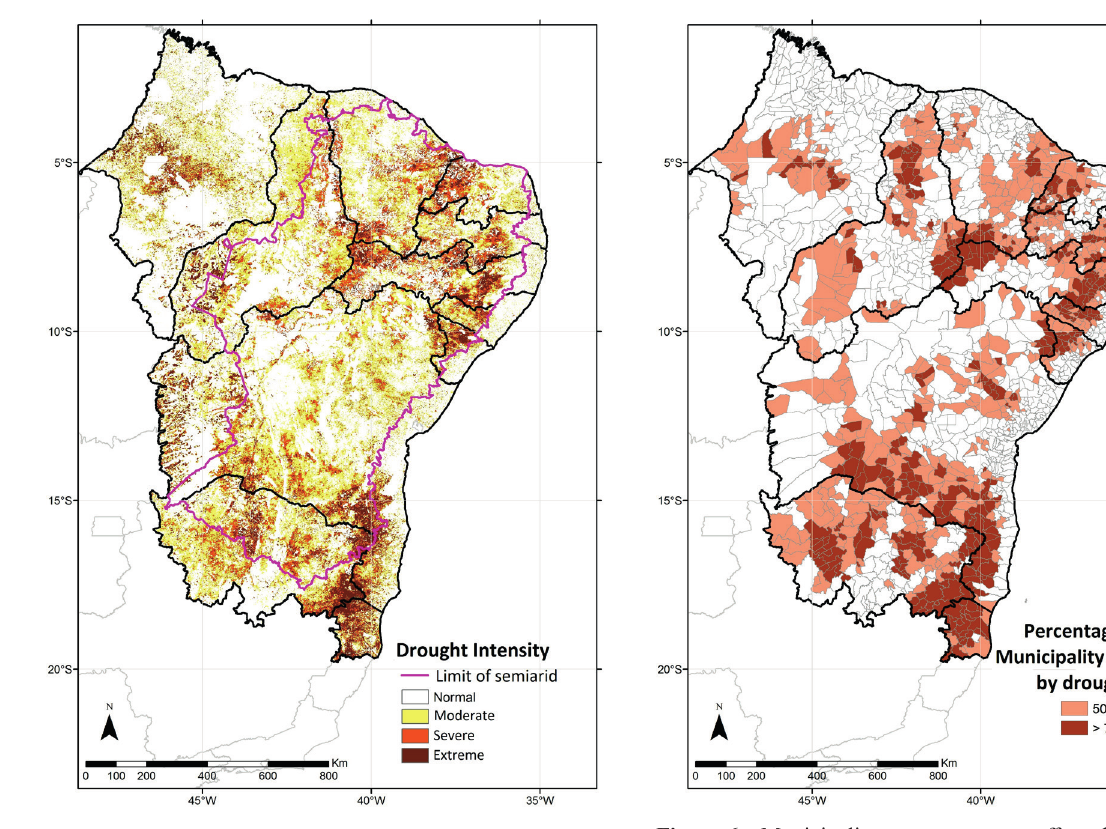
Figure 5 - Drought intensity based on the VSWI anomaly for hydrological year